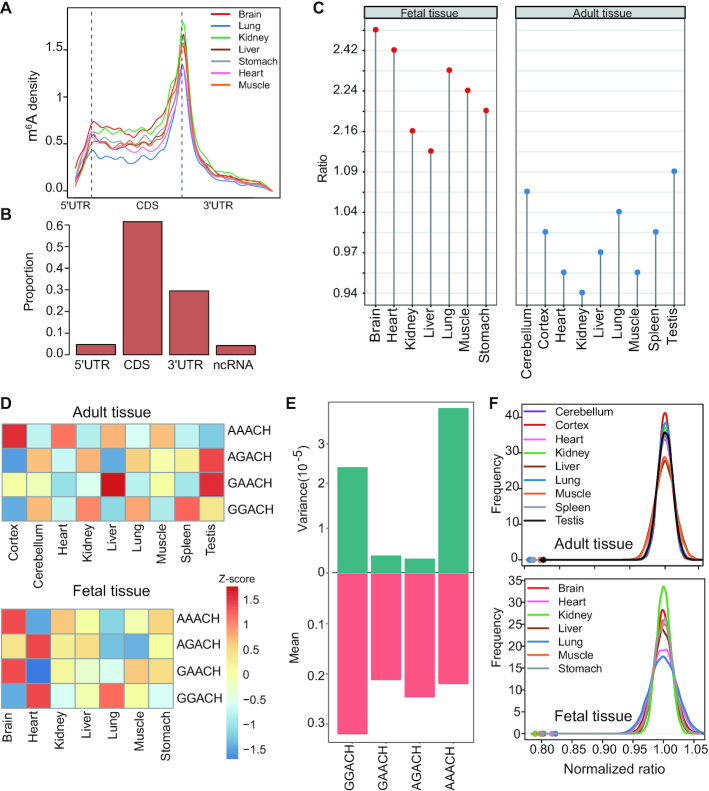
Developmental dynamics of m6A profile. (A) The distribution of m6A sites across the length of mRNA transcripts for 7 fetal tissues. (B) Genic locations of m6A sites of fetal tissues. Sites in seven fetal tissues were merged for analysis. (C) The ratio between the CDS m6A site number and 3′UTR m6A site number in fetal and adult tissues. (D) Heatmap showing the normalized proportion (the values were centered and scaled in the row direction) of 4 m6A sub-motifs in adult and fetal tissues. (E) Variance and mean value of the proportion of 4 sub-motifs across human adult tissues. (F) GGACH and AAACH sub-motifs tend to locate in different windows for all tissue types we studied. Color dots indicate the observed numbers of m6A peaks with both GGACH and AAACH sub-motifs. The distribution of the expected numbers was generated by the shuffled data. P is the fraction of the distribution on the left side of the dots. It is found that the observed numbers of m6A peaks with both GGACH and AAACH sub-motifs are significantly smaller than that of the shuffled data (P < 0.0001). The x-axis is the ratio of the number of windows with both sub-motifs over the mean number of windows with both sub-motifs calculated using the shuffled data.